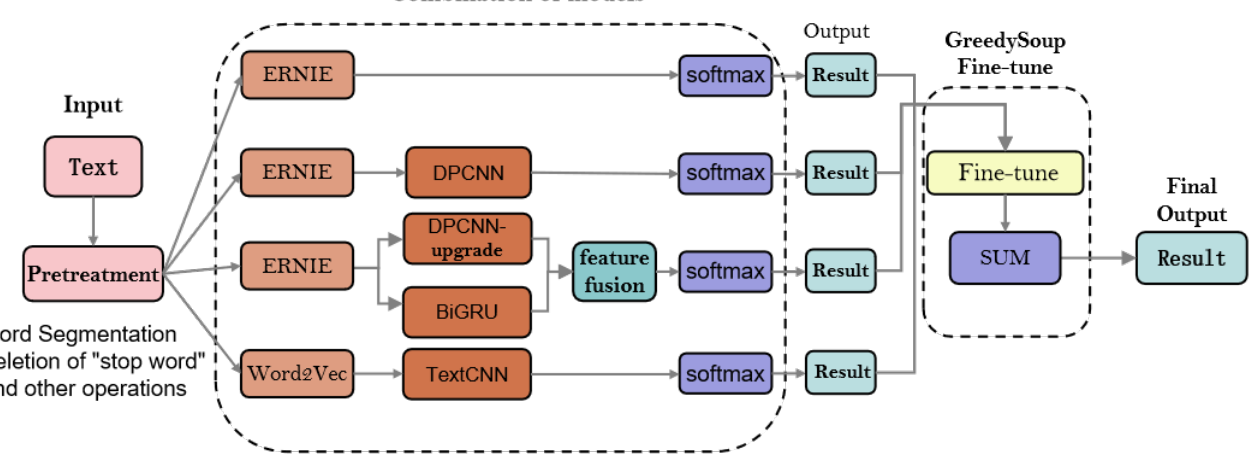
Figure 10. Combined model structure, showing the processing of data in the model combination